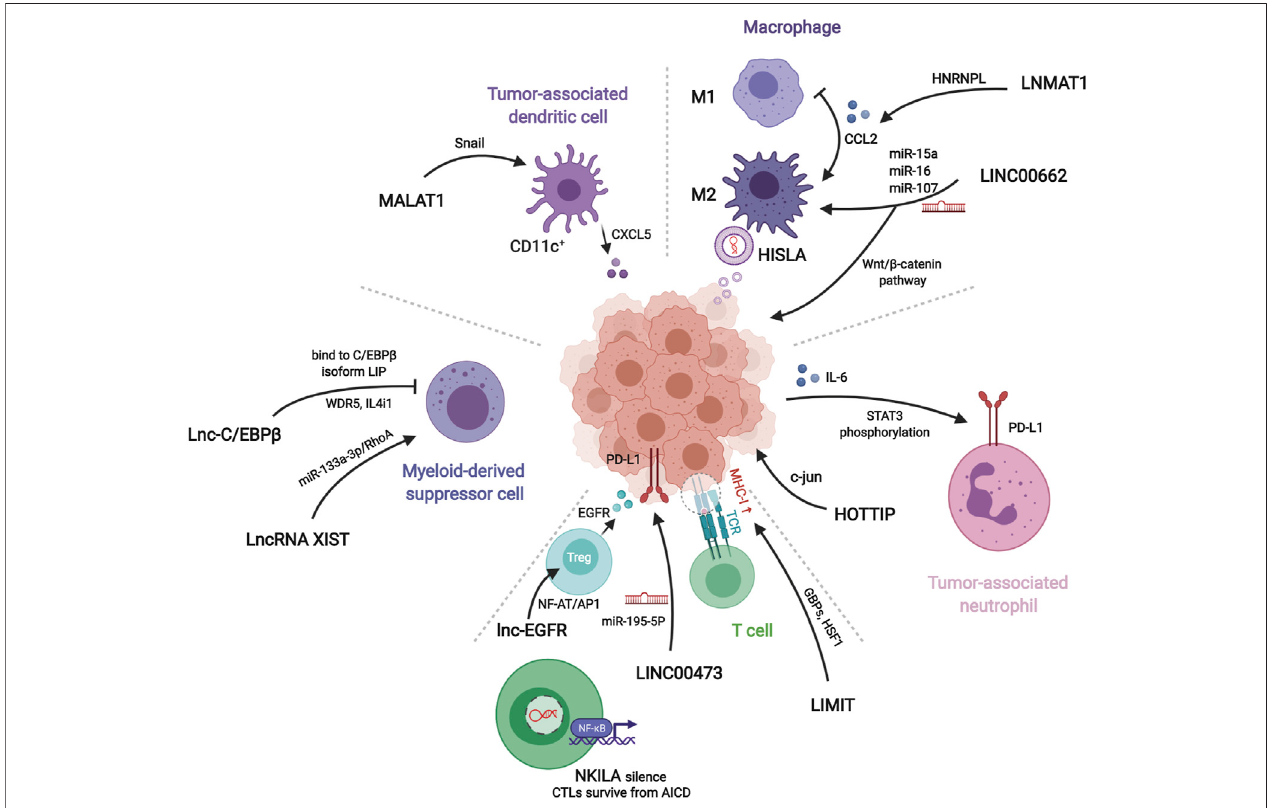
FIGURE 3 | Mechanisms of lncRNAs related to different immune components in tumor microenvironment. LNMAT1, LINC00662, and HISLA regulate macrophages polariztion or tumor growth through chemokine, wnt pathway, or extracellular vesicles, respectively. HOTTIP stimulates tumor cells to secret IL-6 for inducingPD-L1onthesurfaceoftumor-associatedneutrophils.LIMIT,LINC00473,NKILA,andlnc-EGFRmodulaterecognitionandcytotoxicityofTcellstotumorcells. Myeloid-derived suppressor cells and tumor-associated dendritic cells assist tumor immune evasion by lnc-C/EBP β , lncRNA XIST, and MALAT1.